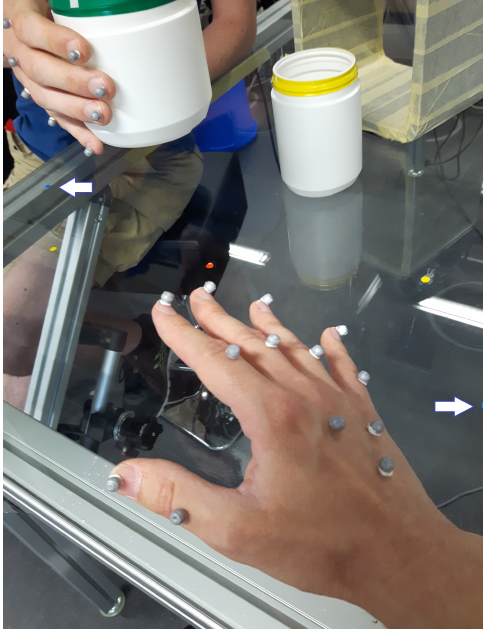
Figure 3. Photo of the experimental situation, seen from the position of the participant sitting on stool R . (Denotations as in Figure 2.) His hand with 13 reflective markers is visible in the lower center. The low number of markers is possible because of the application of inverse kinematics when determining the joint angles—see Maycock et al. [28]. The participant on stool L is visible in the upper left, the rack P in the upper right, one of the plastic cans standing in front of it. (Just for visualisation, normally, the cans are stored on an extra table behind the experimenter.) The points H L and H R are visible as small blue disks close to the left or right image border, respectively. (For better visualisation, white arrows pointing to H L and H R were added.) The points S L and S R are the small yellow disks next to H L and H R , respectively. Point T is the small red disk between them, close to the center of the picture. The situation of a direct hand-over of a small, empty can in the moment is shown, when the giver on stool L is holding the can over point T , and the receiver on stool R reaches for the can. (This would be an example of an incorrect behaviour of the participants, as a green border of the can signalises an indirect hand-over. Trials like this were sorted out. In the experiment, markers were also put at the upper border of the